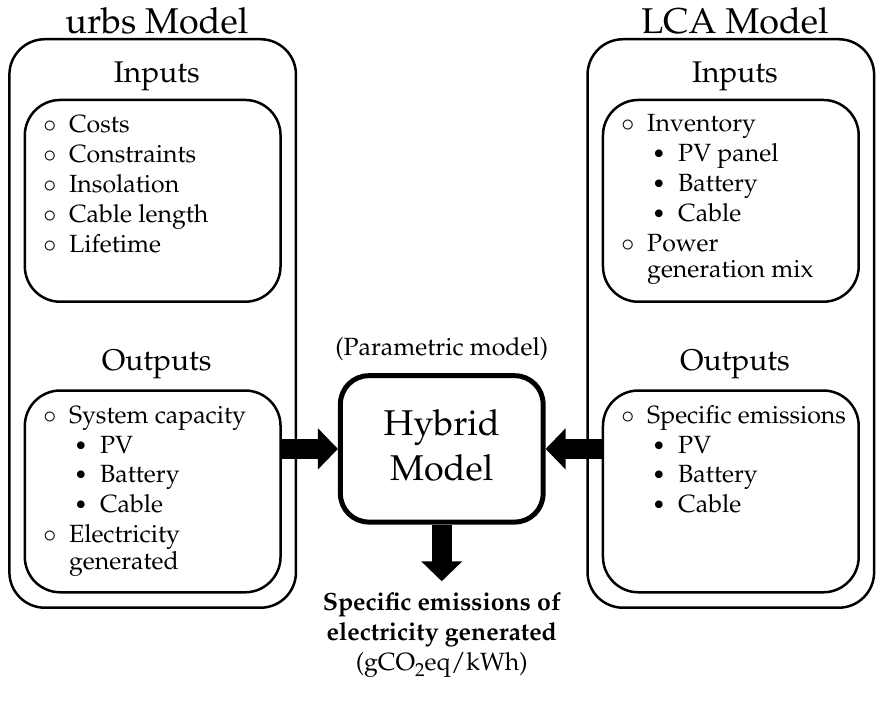
Figure 1. urbs -LCA